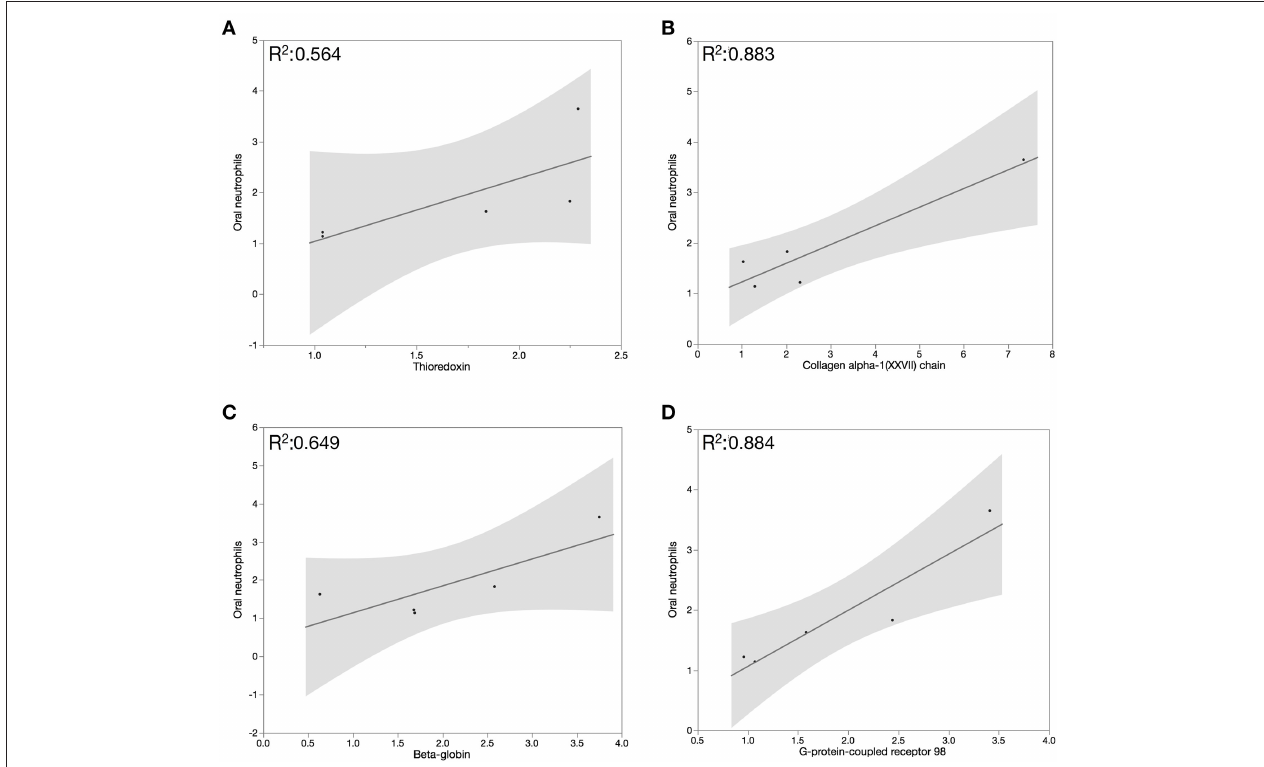
FIGURE 4 | Pearson correlation assessment between salivary proteins abundance and oral neutrophils quantification demonstrated that oral neutrophil numbers correlated moderately with salivary β -globin (A) and thioredoxin (B) and strongly with (C) collagen alpha-1(XXVII) chain and (D) G-protein coupled receptor 98 in the inflammatory and resolution phases of